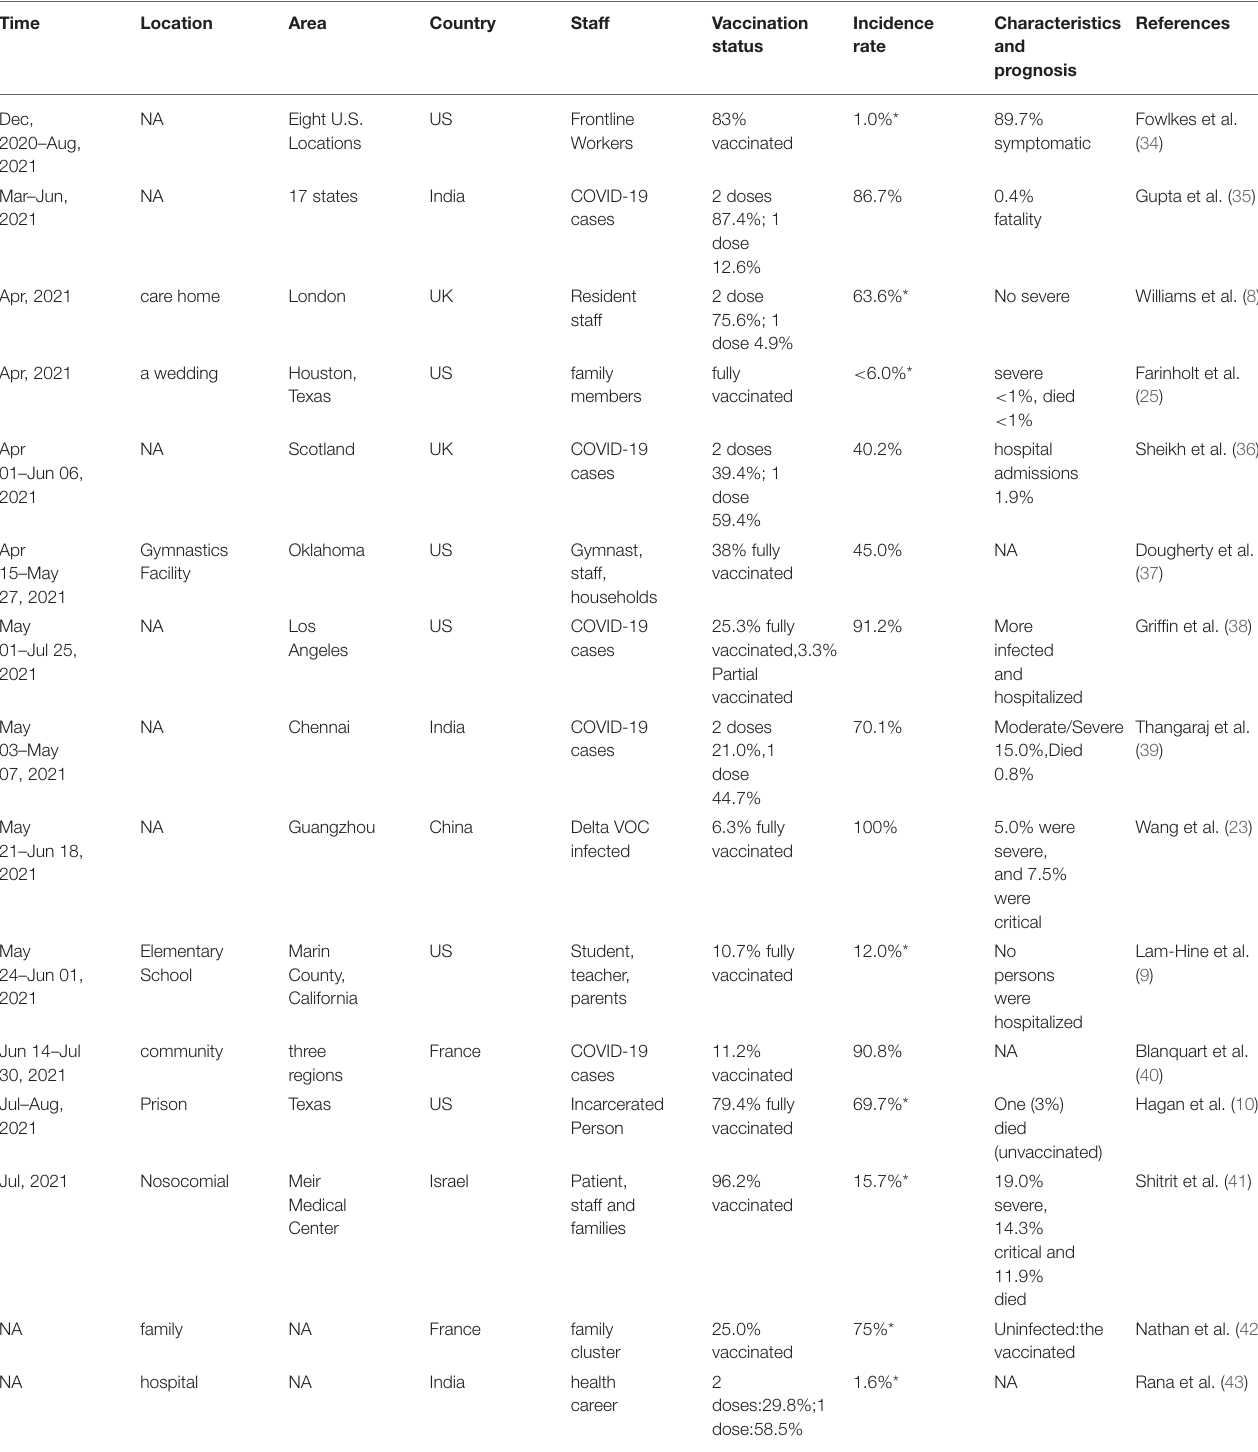
TABLE 1 | Reports of vaccine breakthrough